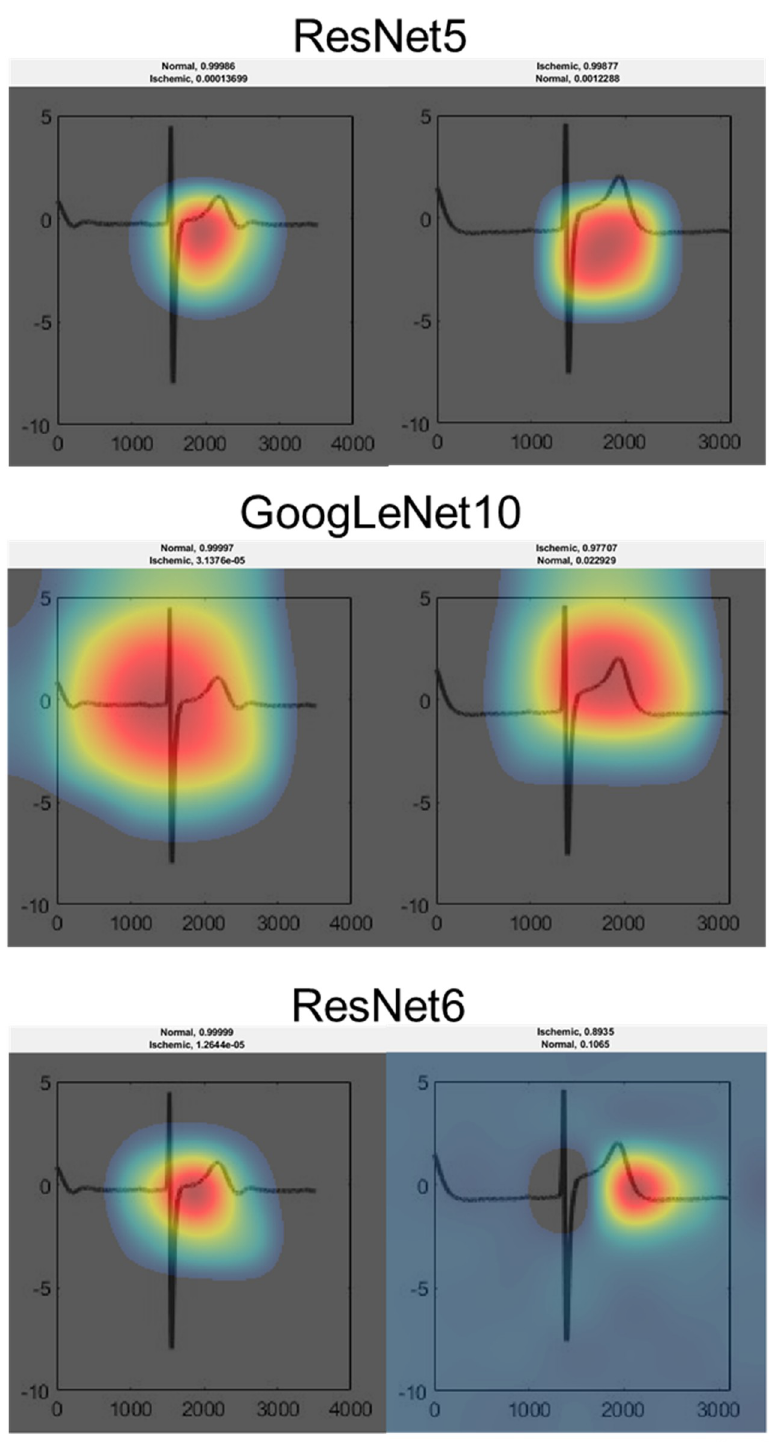
Fig 5. Visualization of network activation patterns of the three best performing CNN. Red regions contributed most to the network class prediction. ResNet5 bases its prediction on the area under the ST–segment and the T–wave. GoogLeNet10 is activated by the QRS–complex and the J–point for the non–ischemic state, and by the ST–segment and the T–wave for the ischemic state. ResNet6 bases its prediction on the ST–segment for the non–ischemic state, and on the end of the T–wave for the ischemic state. Please note the rather uncertain prediction of ResNet6 on the ischemic ECG.